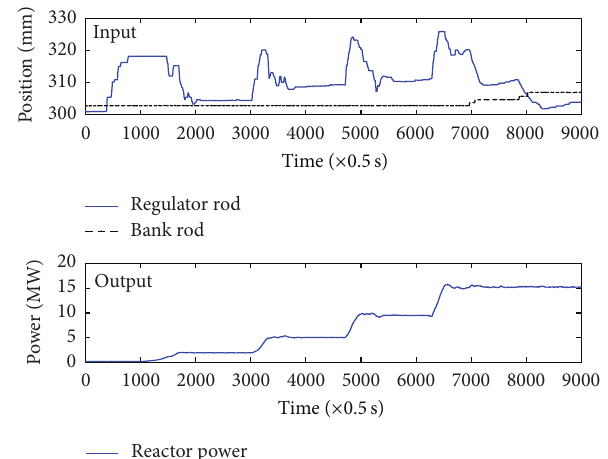
Figure 3: Input and output data of RGS-GAS experiment.